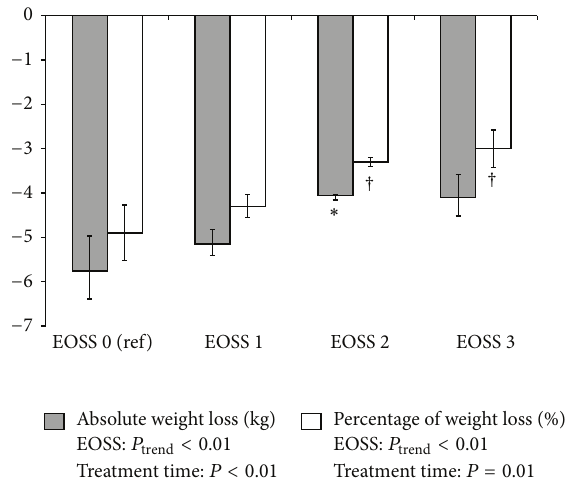
Figure 2: Achieved absolute (kg) and percentage of weight loss relative to initial body weight in patients attending a publicly funded multisite weight management clinic among EOSS stages 0 to 3. Treatment time is in months. EOSS = Edmonton Obesity Staging System; Ref = referent group. Analyses were adjusted for age, sex, initial BMI, and treatment time. ∗ Significantly different from EOSS stage 0 for absolute weight loss ( 𝑃 < 0.05 ). † Significantly different from EOSS stage 0 for percentage of weight loss ( 𝑃 < 0.05